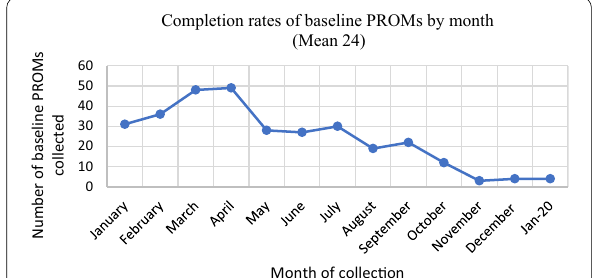
Fig. 2 Monthly baseline completion rates in Organisation B between January 2019 and January